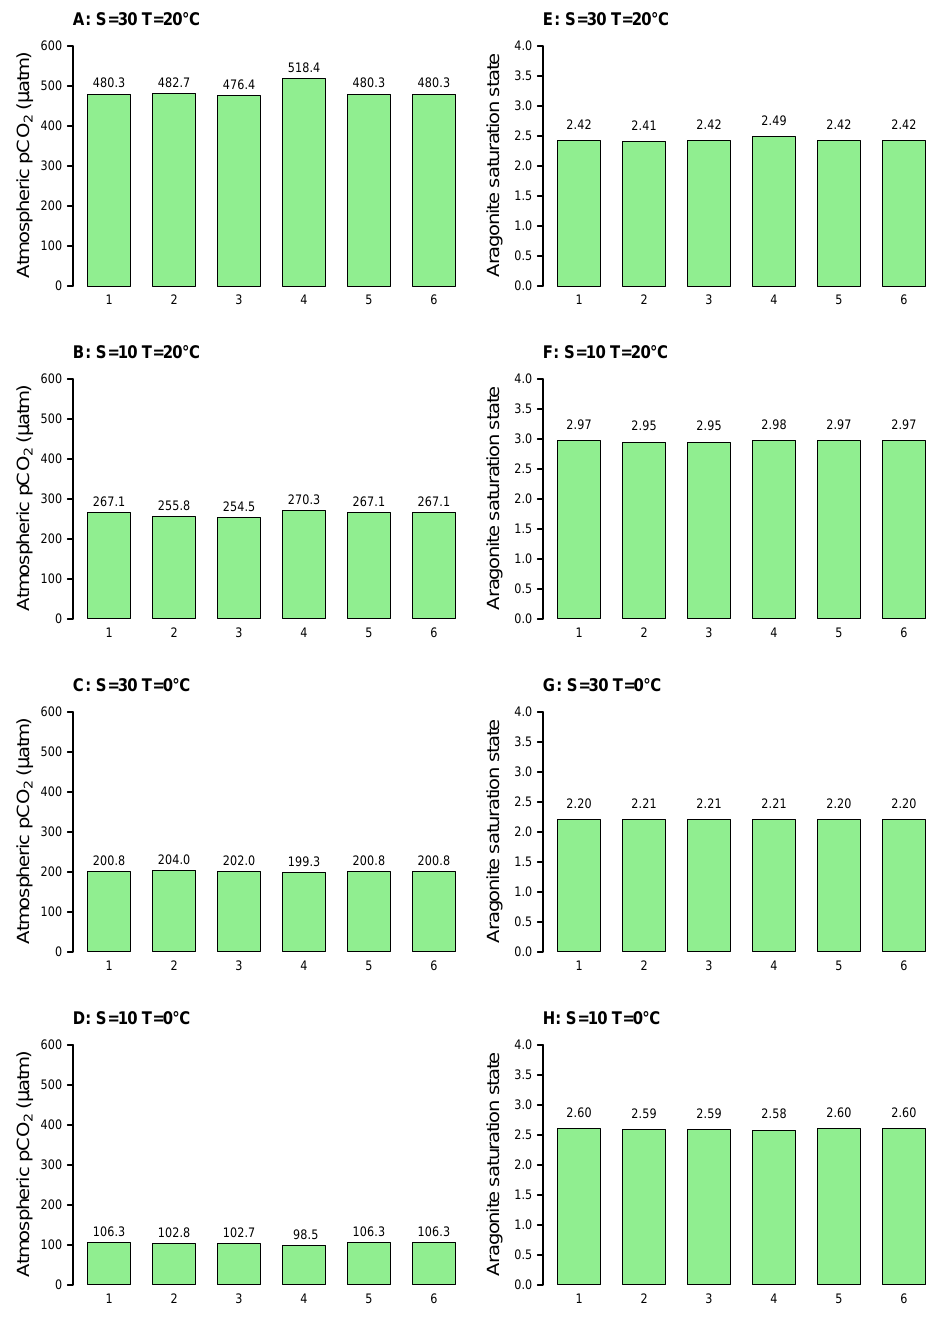
Figure 4. p CO 2 and Ω a for four combinations of salinity ( S ) and temperature ( T ) and using di ff erent formulations for the dissociation constants of carbonic acid, hydrogen fluoride and hydrogen sulphate (see Table 3). Calculations were performed with seacarb using constant values of total alkalinity (2300 × 10 − 6 molkg − 1 ) and total carbon (2100 × 10 − 6 molkg − 1 ) and with concentrations of total phosphate and total silicate of 0 × 10 − 6 molkg − 1